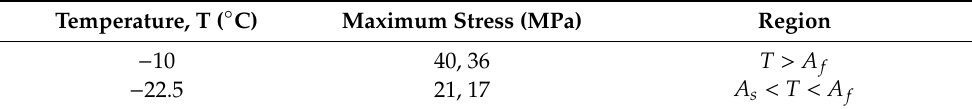
Table 2. Simulated operating